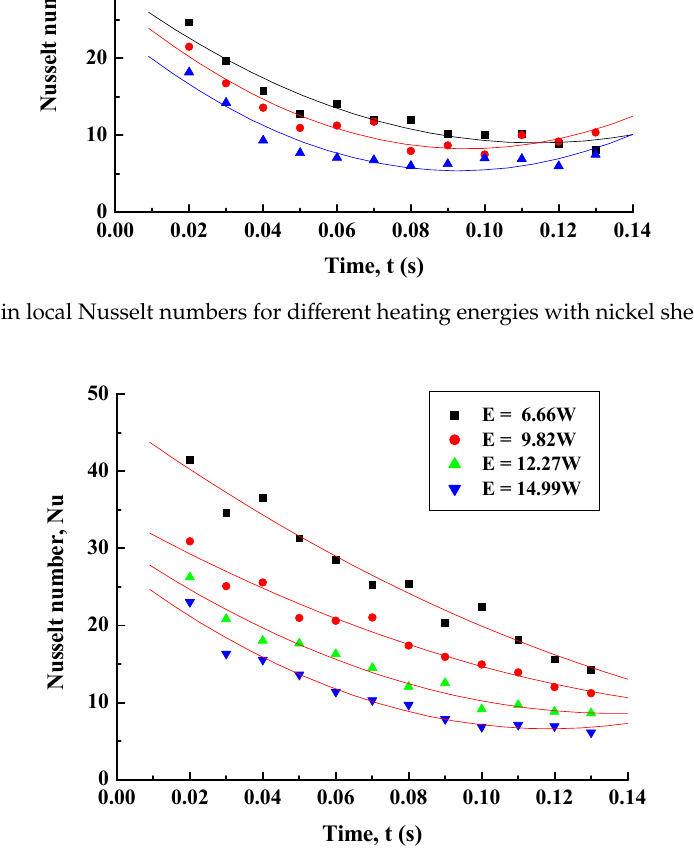
Figure 9. Variation in local Nusselt numbers for different heating energies with nickel sheet ( δ = 0.0075 mm).